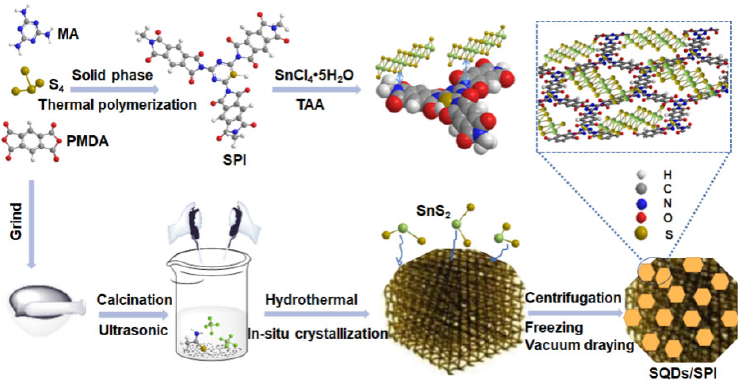
Scheme 1. Schematic illustration of the fabrication process of